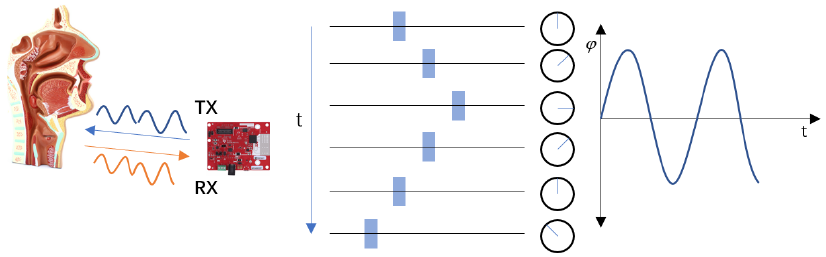
Figure 2. Vibration − induced phase change. Figure 2. Vibration-induced phase